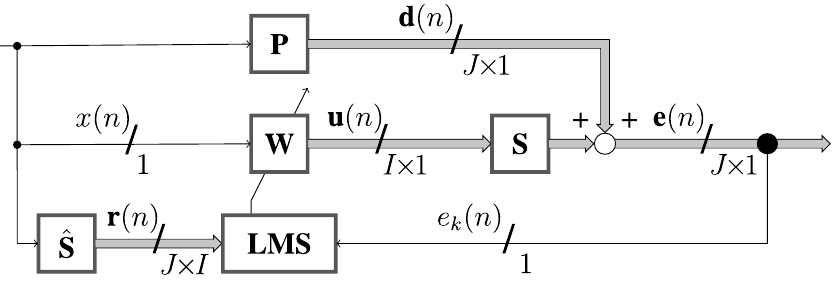
Figure 6. Multi-channel control system with the Switched-error FxLMS